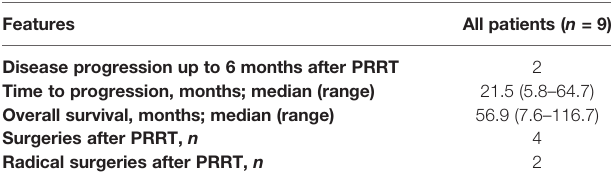
TABLE 4 | Long-term outcome of the patients who underwent PRRT as neoadjuvant therapy. Features